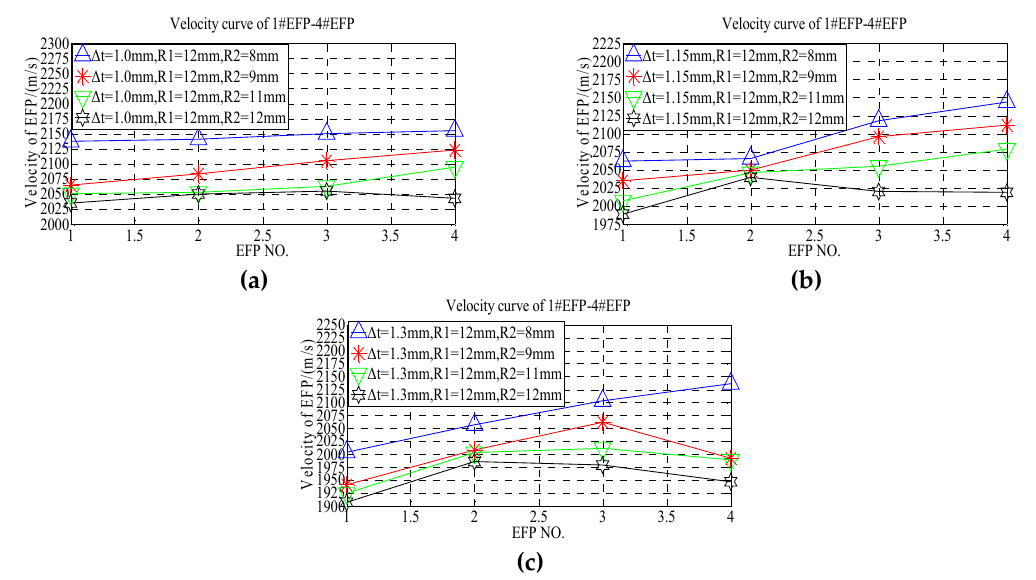
Figure 16. Velocity curve of 1#EFP-4#EFP:( a ) the center thickness of liner is 1 mm; ( b ) the center thickness of liner is 1.15 mm; ( c ) the center thickness of liner is 1.3 mm.